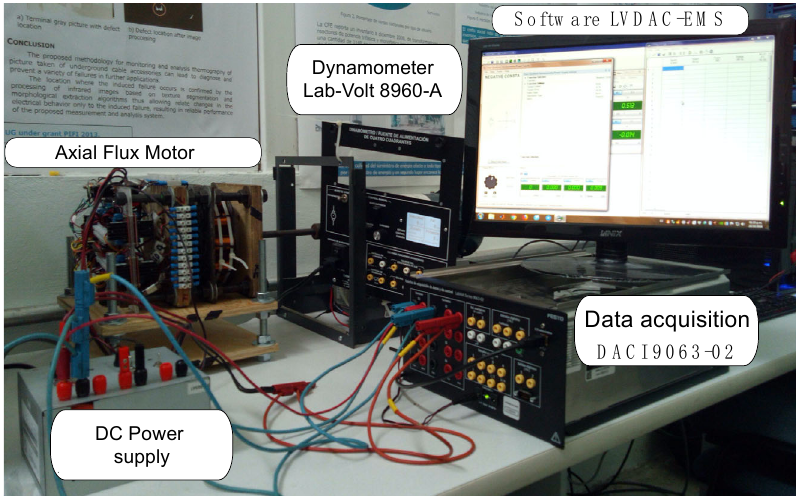
Figure 11. System used to measure dynamic characteristics.